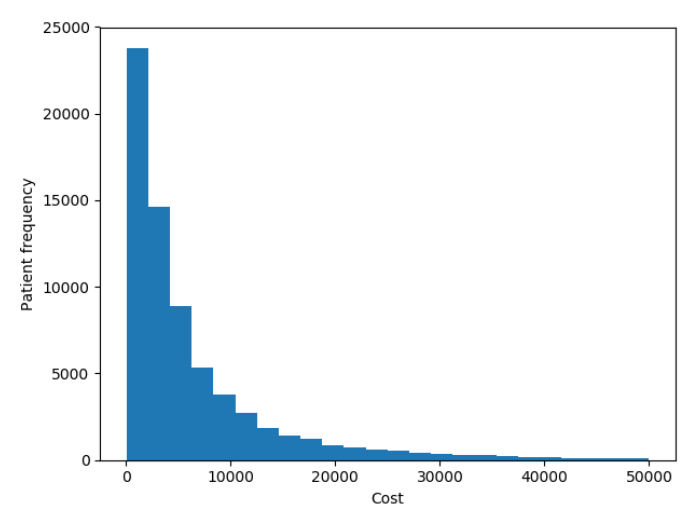
Figure 5. Patients costs distribution.